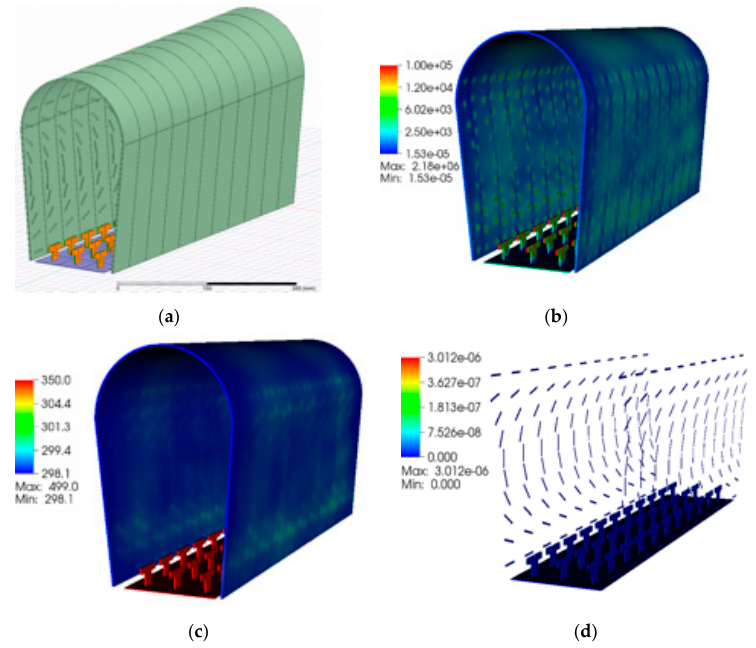
Figure 9. Calculated results of the antenna array and radome: ( a ) geometrical view, ( b ) electric field with dimensions of V/m, ( c ) temperature field with dimensions of K, and ( d ) strain field with dimensions of m.